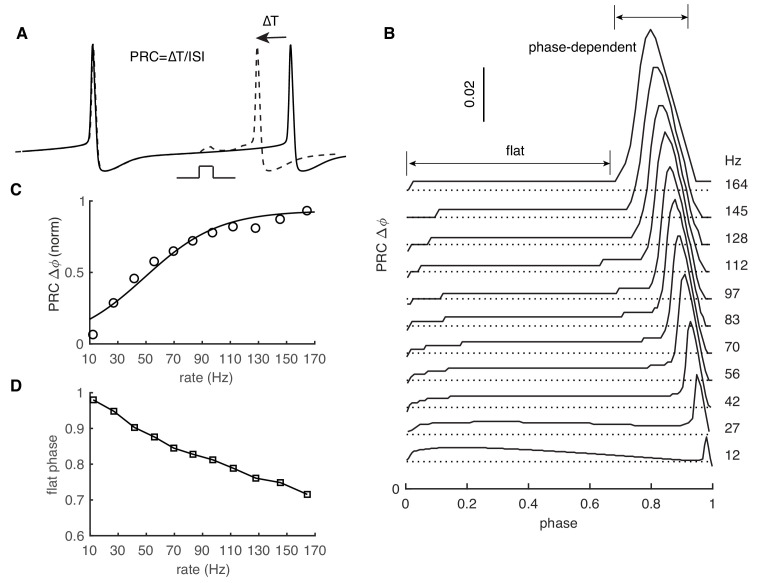
PRC exhibits strong rate adaptation in PC model.(A) Schematic representation of the definition and computation of PRCs. The current pulse has a duration of 0.5 ms and an amplitude of 50 pA. Different spike rates were achieved by somatic current injection (Couto et al., 2015; Phoka et al., 2010). (B) The rate adaptation of the flat part and the phase-dependent PRC peak. (C) PRC peak amplitudes at different firing rates fitted by the Boltzmann function. (D) Duration of the flat phase at different firing rates.